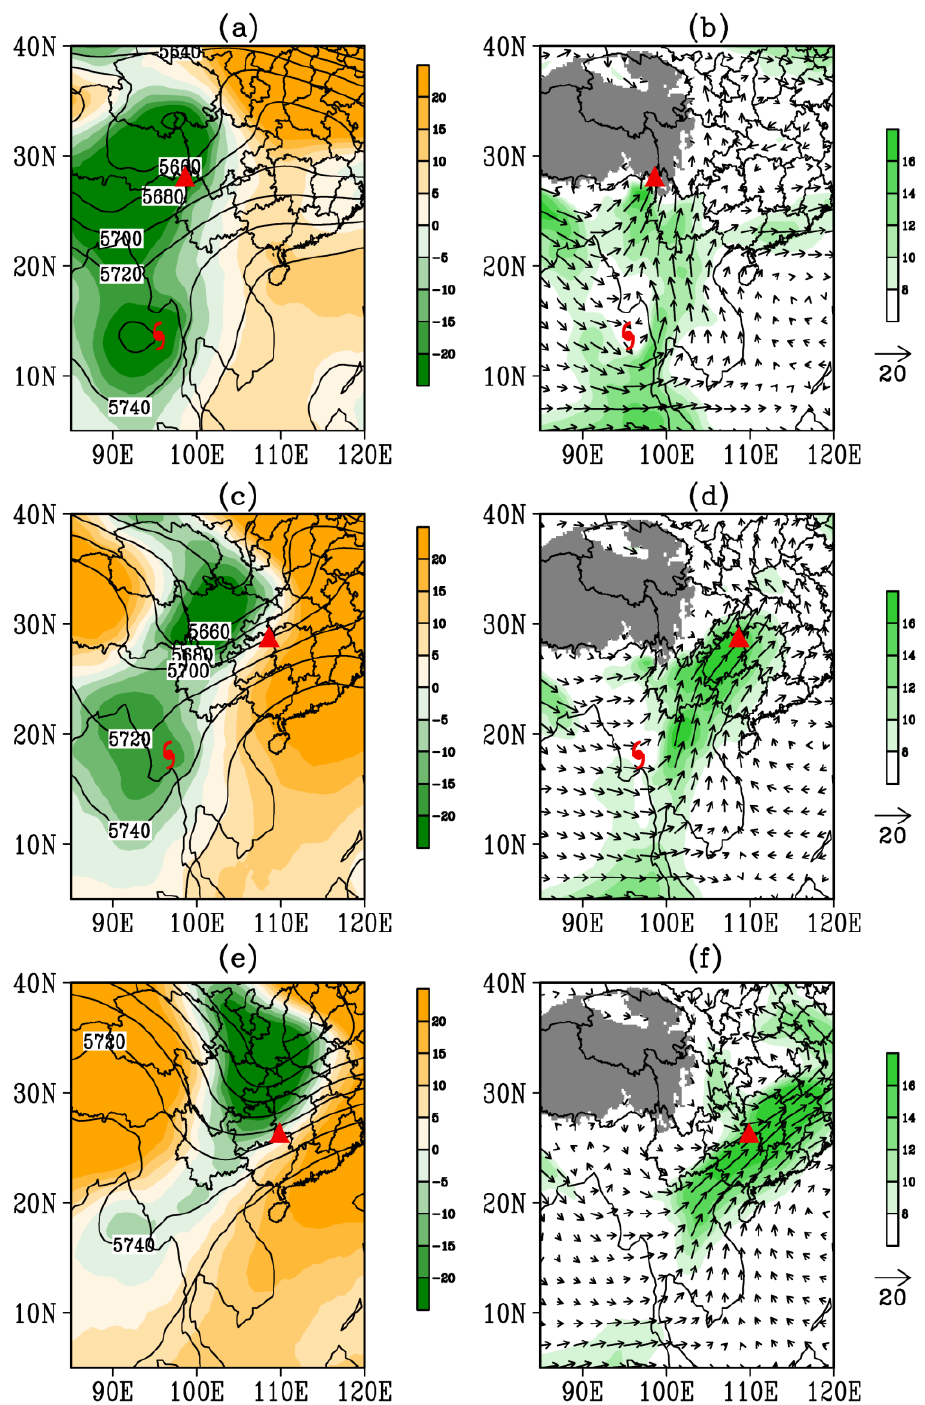
Figure 7. Geopotential height (solid lines, units: m) and anomalies (shaded, units: m) at 500 hPa for ( a ) 11 May 2002, ( c ) 12 May 2002 and ( e ) 13 May 2002. Horizontal wind (vectors, units: m s −1 ) and horizontal wind speed (shaded, units: m s −1 ) at 700 hPa for ( b ) 11 May 2002, ( d ) 12 May 2002 and ( f ) 13 May 2002. The locations of the tropical cyclones are indicated by black tropical storm symbols. The centers of maximum precipitation are indicated by triangle symbols.